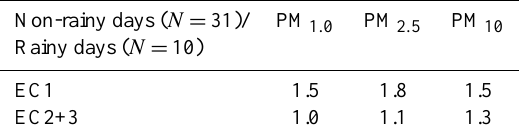
Table 4. The ratios of EC1 and EC23 concentrations for non-rainy days to those for rainy days in PM 1 . 0 , PM 2 . 5 , and PM 10